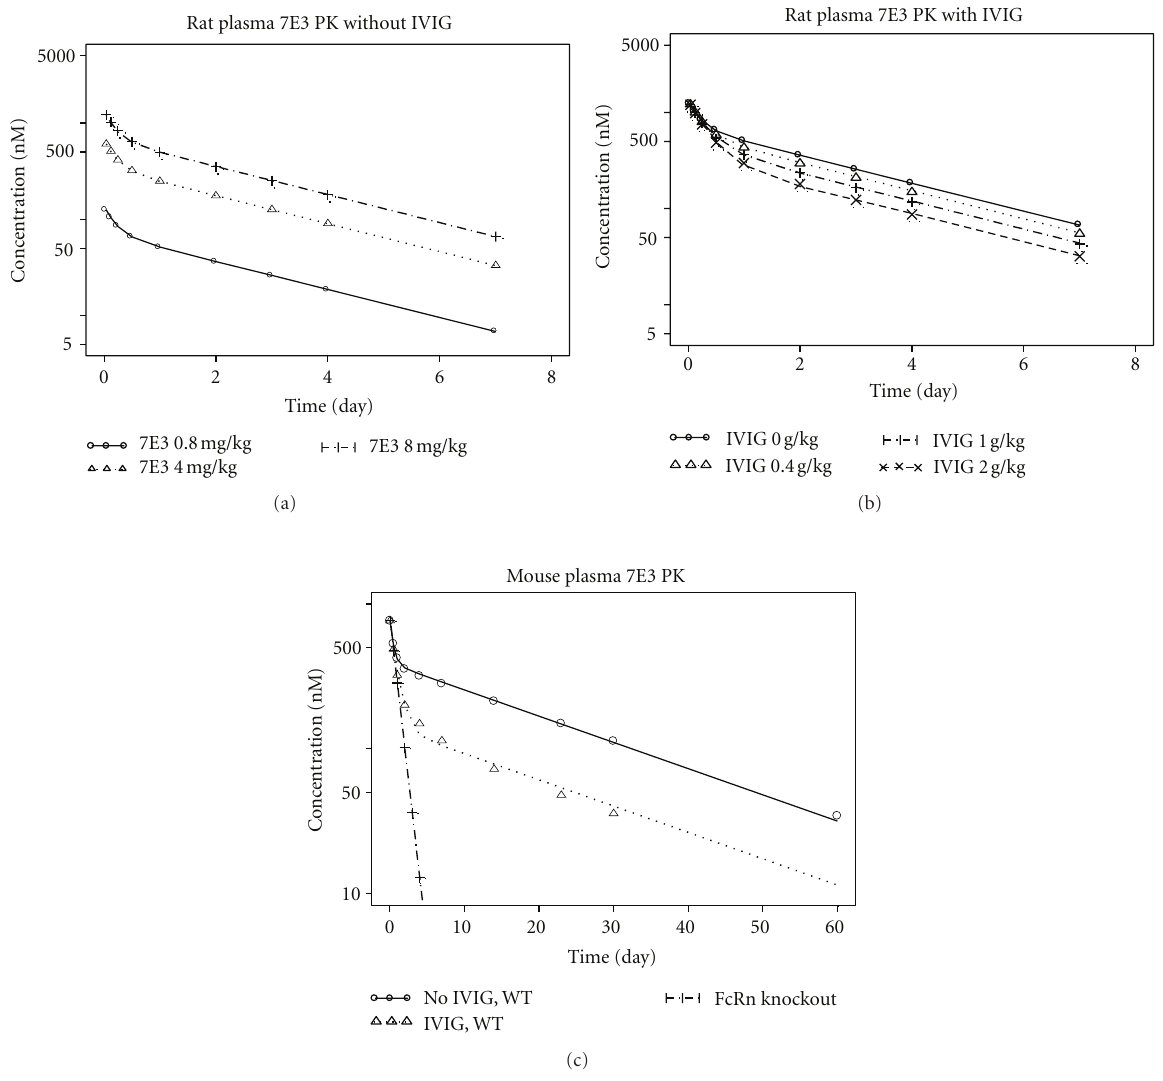
Figure 2: Cuto ff model fitting of plasma 7E3 PK data that were simulated using Hansen’s models. (a) Rat 7E3 PK data fitting at indicated dose levels without IVIG. (b) Rat 7E3 PK data fitting when 8 mg/kg 7E3 were dosed concomitant with IVIG of indicated dose levels. (c) Mouse 7E3 PK data fitting when 8mg/kg 7E3 was given to FcRn WT or KO mice, with or without 1g/kg